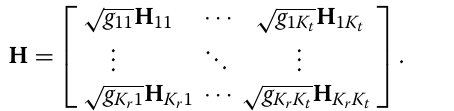
transmitter consists of K t RAUs, each of which has N t antennas and is connected to a baseband processing unit (BPU) via fiber. Likewise, the distributed antenna array at the receiver consists of K r RAUs, each having N r anten- nas and also being connected to a BPU by fibers. Such a MIMO system shall be referred to as a ( K t , N t , K r , N r ) - distributed MIMO (D-MIMO) system. When K t = K r = 1, the system reduces to a conventional co-located MIMO (C-MIMO) system.